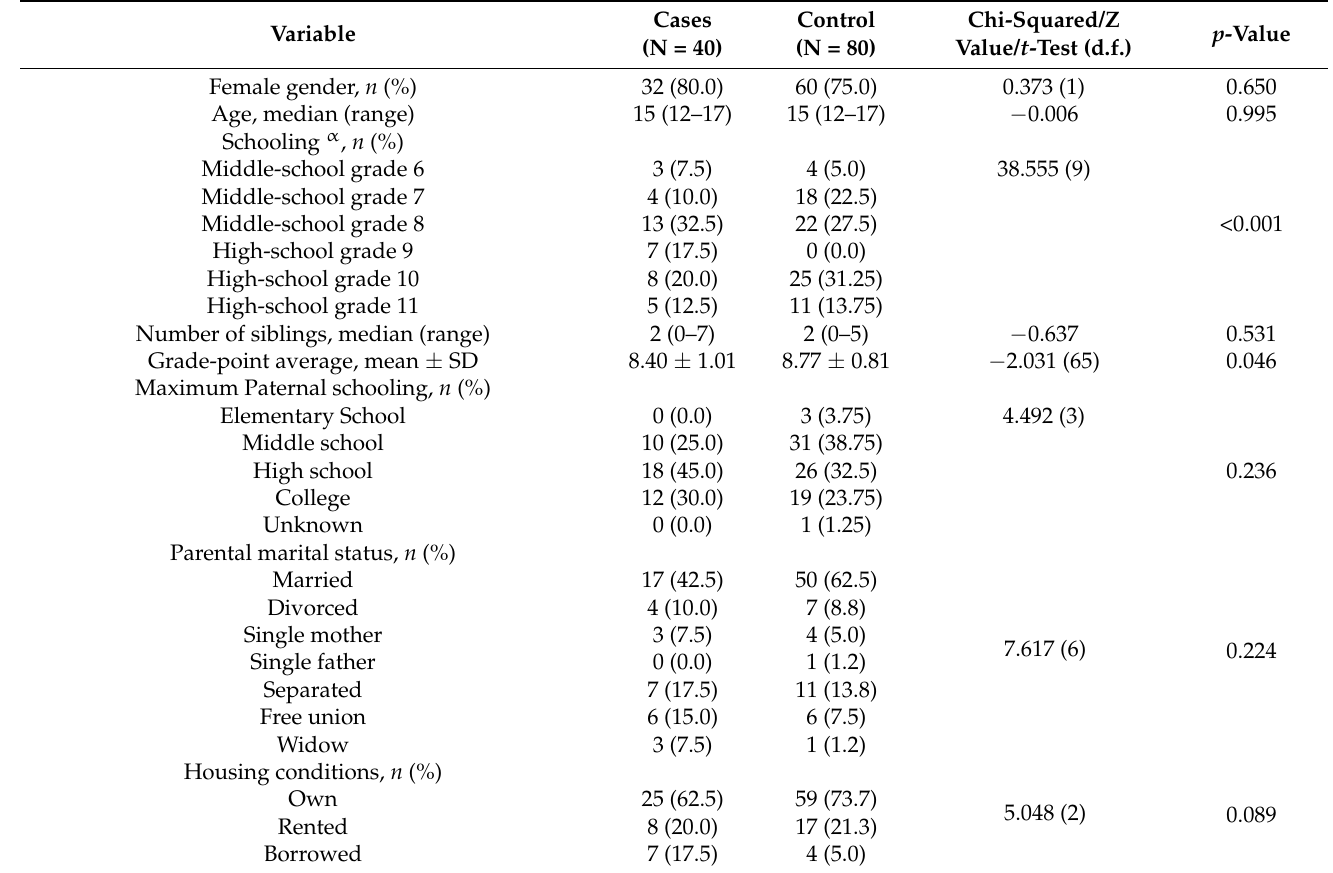
Table 1. Comparison of sociodemographic variables between both study